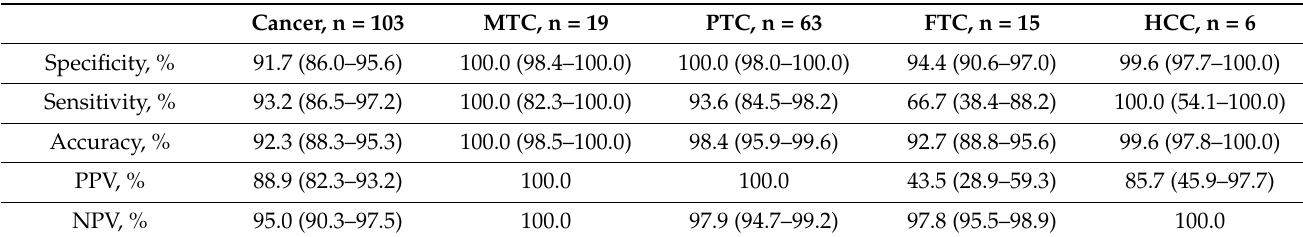
Table 2. Diagnostic characteristics of the molecular classifier for malignant tumors (with 95% confidence